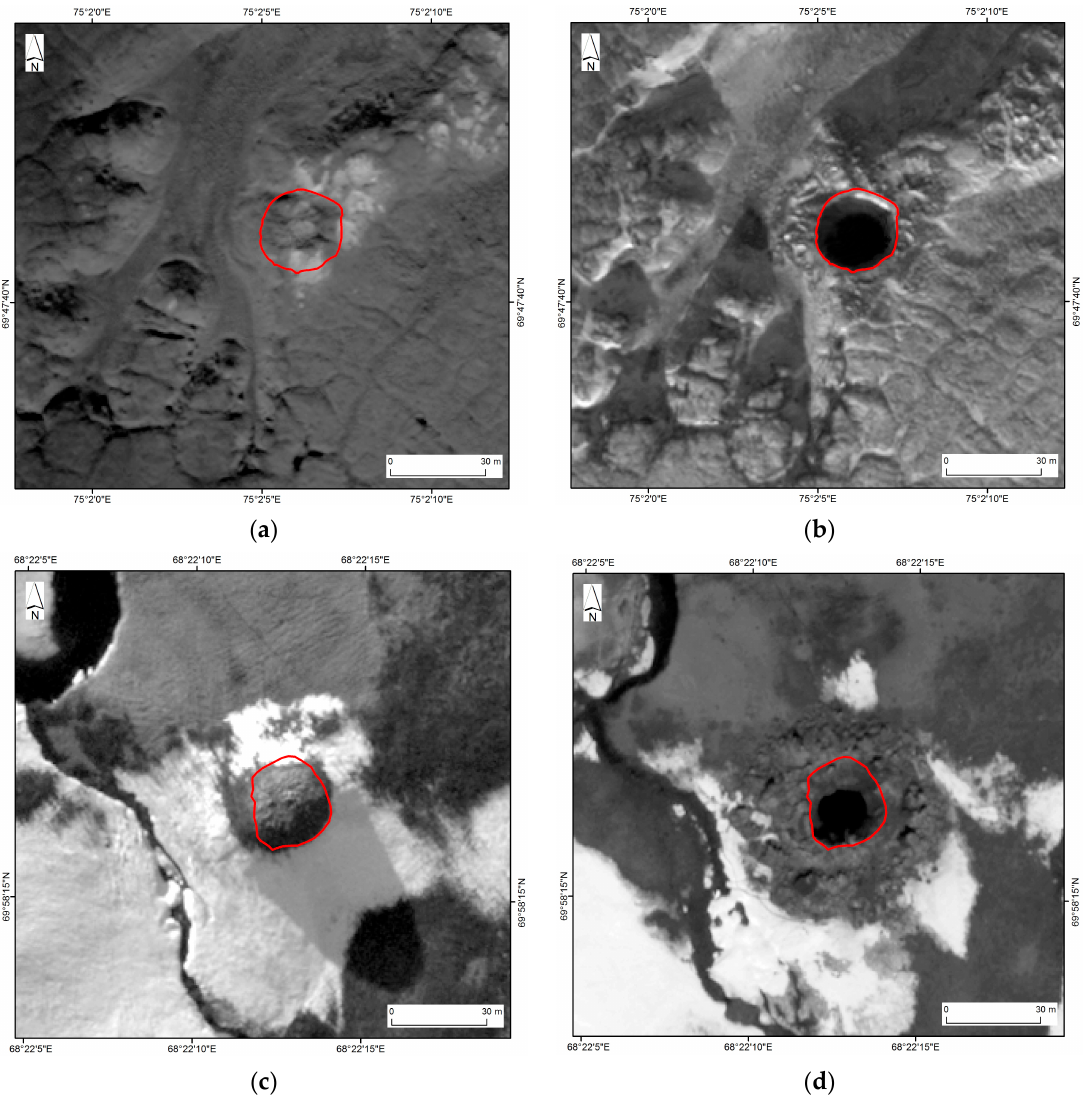
Figure 3. Satellite images of the AntGEC: ( a ) a WorldView-2 image dated 21 August 2013 (before the crater formation); ( b ) a WorldView-1 image dated 11 October 2014 (after the crater formation). The red line represents the AntGEC crater edge as of 11 October 2014; Satellite images of the GEC-1: ( c ) a WorldView-1 image dated 09 June 2013 (before the crater formation); ( d ) a WorldView-1 image dated 15 June 2014 (after the crater formation). The red line represents the GEC-1 crater edge as of 15 June 2014.